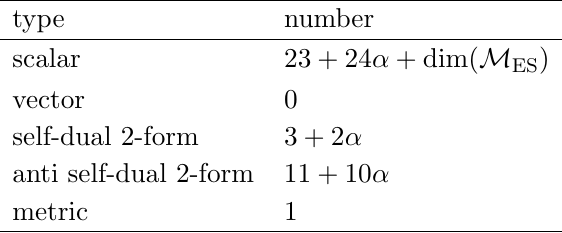
Table 2 . Six-dimensional (cid:12)elds after the compacti(cid:12)cationof type IIB supergravity on the Enriques surface. We included also the number of odd (cid:12)elds under the projection, they can still contribute to the three-dimensional (cid:12)eld